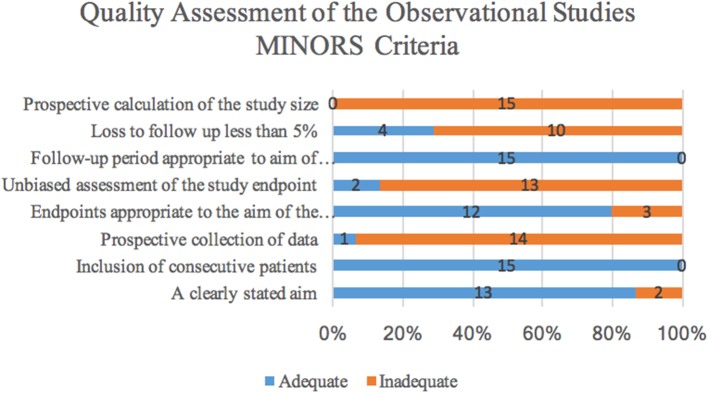
Distribution of the adequacy of MINORS criteria showing the amount of articles scoring adequate or inadequate for the criteria.